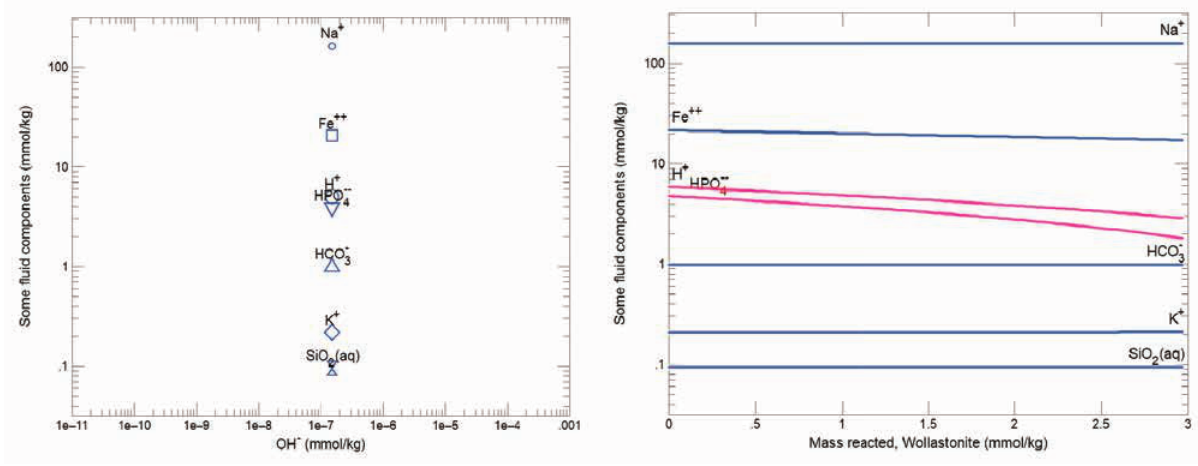
Figure 4: a) Left: Initial concentrations of species in sediments of constructed wetland from agriculture runoff; b) Right: Concentrations of species in sediments of constructed wetland after addition of